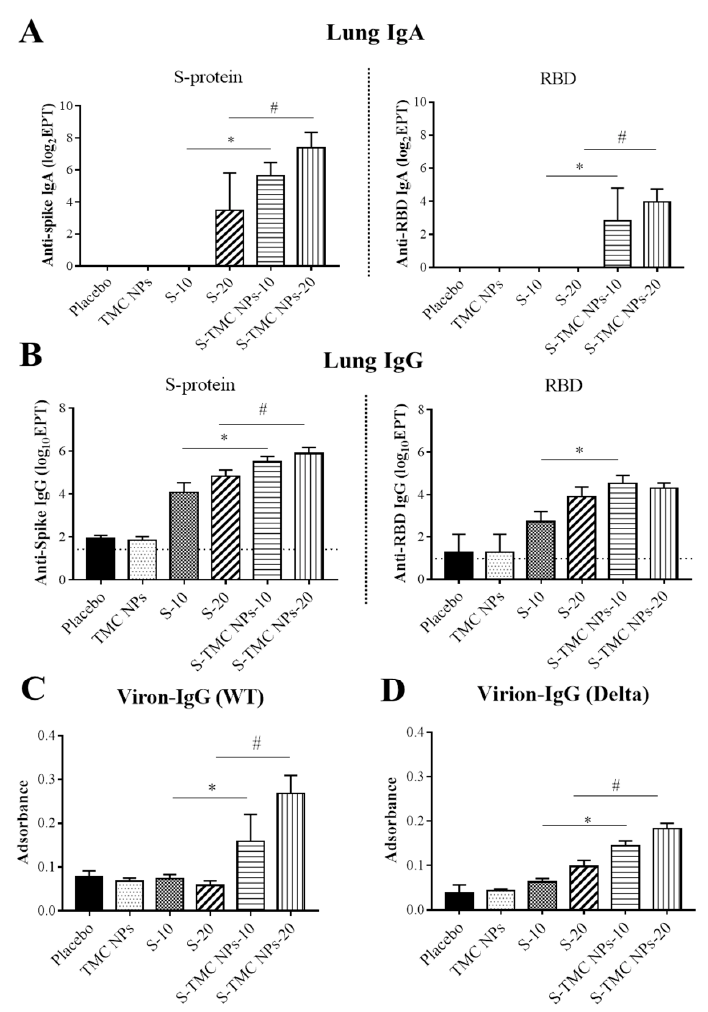
Figure 5. Mucosal responses to soluble S-protein or S-TMC NPs in the lungs of immunized mice. Lungs of immunized mice were collected on Day 45 and processed by homogenization. The levels of S- and RBD-specific IgA ( A ) or IgG ( B ) antibodies in lung homogenates were detected by indirect ELISA. Binding antibodies against SARS-CoV-2 particles (virion–IgG) of WT ( C ) and Delta variant viruses ( D ) present in the lung homogenates diluted at 1:100 was determined by capture ELISA. Data are means ± SD ( n = 4); * and # indicate a significant difference between soluble S-protein and S-TMC NPs at 10 and 20 μ g/dose, respectively ( p < 0.05). Dotted line indicates the LOD of the assay.